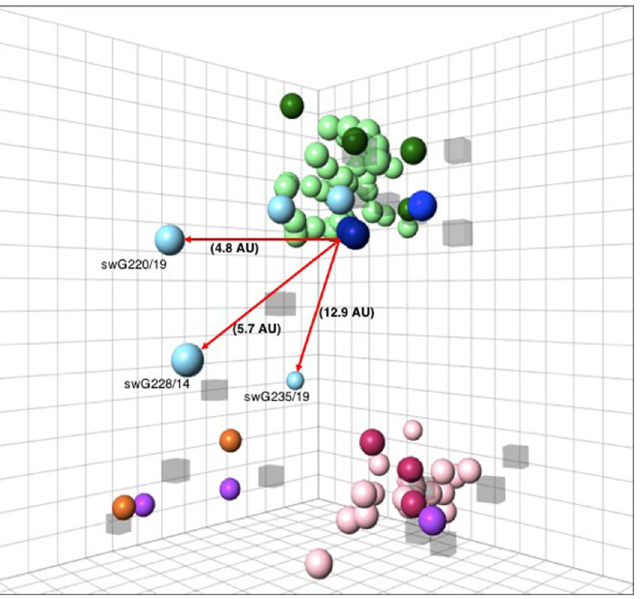
Figure 3. Antigenic diversity of H1 swIAV isolated in Belgium and the Netherlands in 2014–2019. A 3D map was constructed based on the reactivity of the isolates in HI assay, with sera against the reference viruses, which included: dark green sphere EU H1av, maroon sphere EU H1hu, dark blue sphere H1pdm09, blue sphere US H1γ, orange sphere US H1δ1 and purple sphere Human H1. The H1 isolates are colored using lighter shades of the color of the reference viruses belonging to the same or related lineage: light green sphere EU H1av, pink sphere EU H1hu and light blue sphere H1pdm09. The virus strains are shown as spheres while the respective antisera are shown as semi-transparent cubes. Antigenic distances of the three H1pdm09 outliers from the H1pdm09 reference virus (CA09) are shown with red arrows. The squares in the grid represent antigenic distances. One square is equal to a two-fold change in HI titer, which is equal to 1 antigenic unit (AU). Analysis of the table vs map distance was conducted generating a moderately high r 2 score value (r 2 =